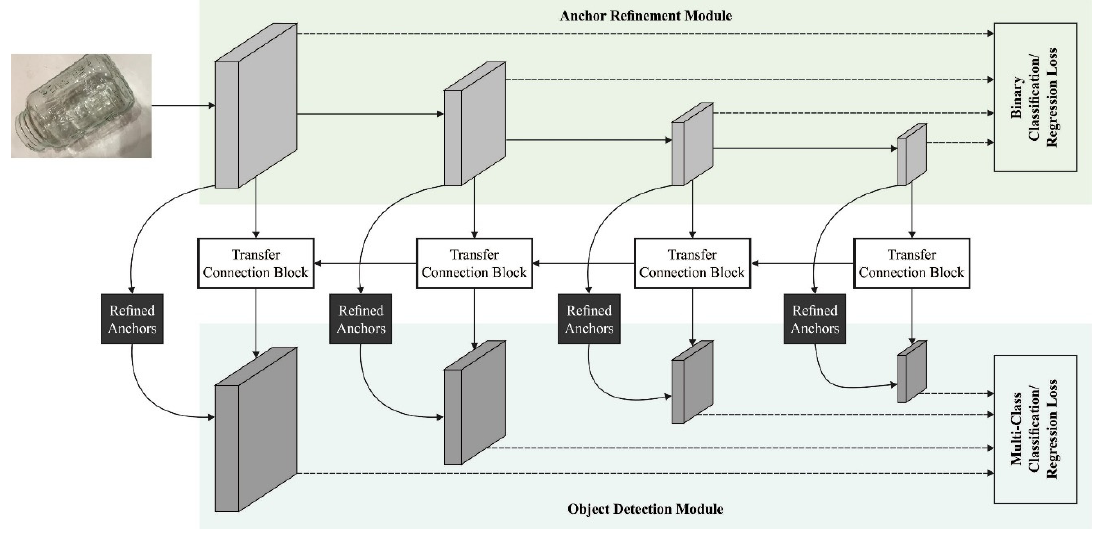
Figure 1. Schematic representation of RefineDet architecture.